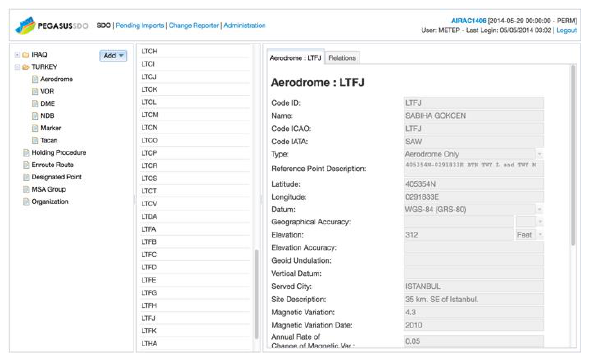
Figure 5. A screenshot from web based data management